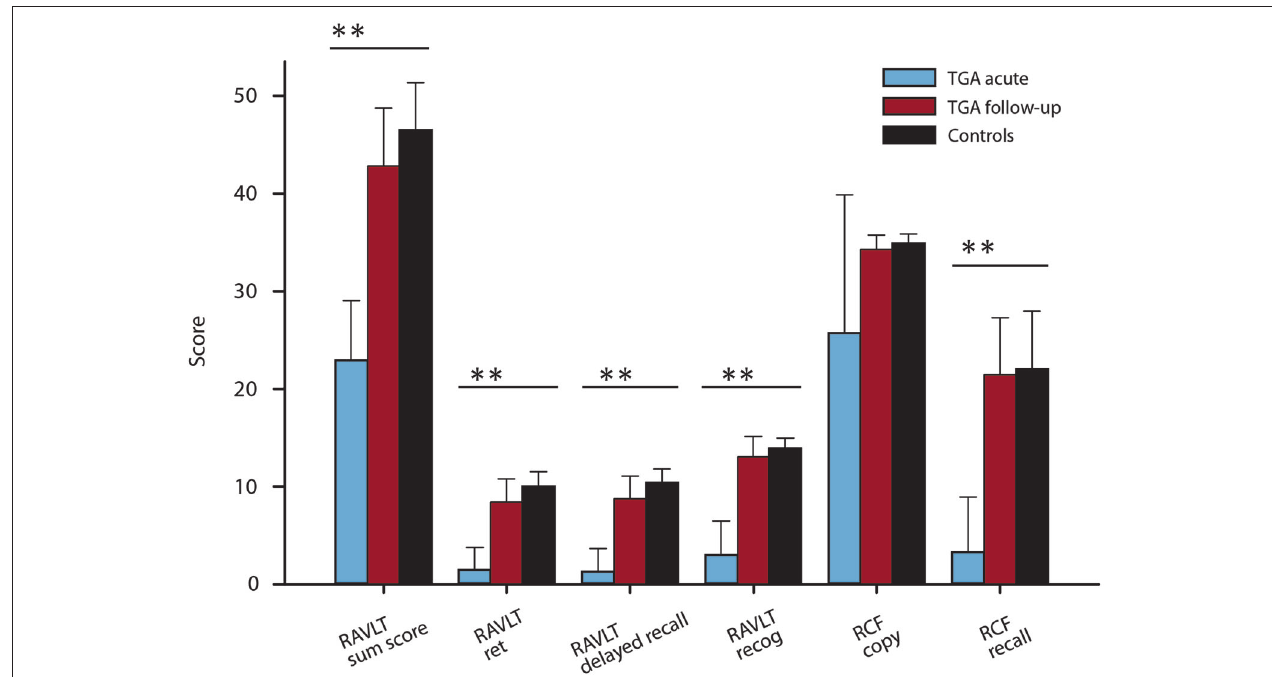
FIGURE 2 | Verbal and visuoconstructive memory results of the RAVLT and the Rey-Osterrieth complex figure of TGA patients (acute and follow-up) (mean ± SD) . P values from t tests; ** P < 0.01. Control values are from Bartsch et al. (2011).